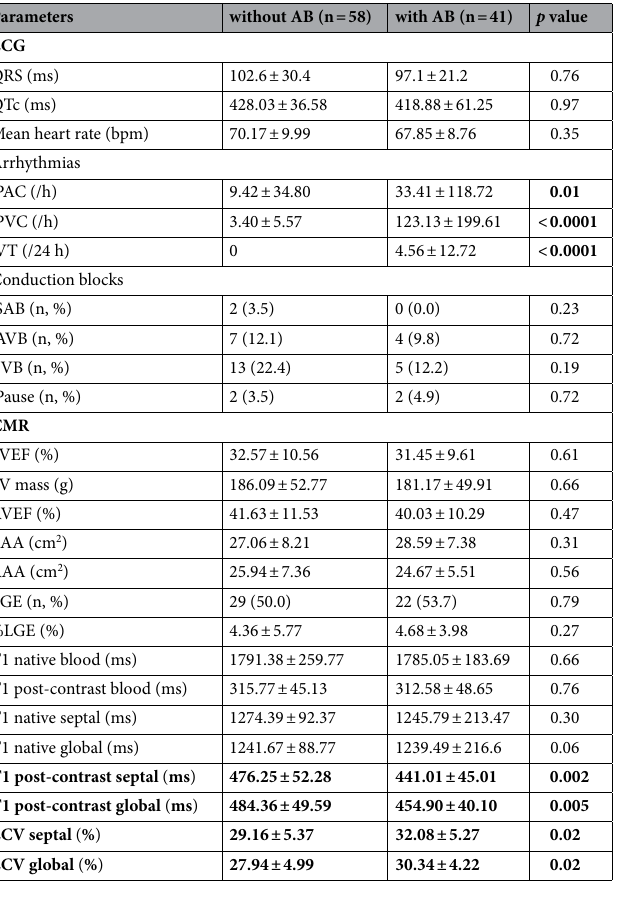
Table 2. Comparison of ECG and CMR findings between DCM patients with and without AB. Values are mean ± SD or n (%). AB arrhythmic burden, ECG electrocardiogram, QTc corrected QT, PVC/PAC premature ventricular/atrial contractions, 24 h/h 24 h/hour, VT (non-sustained or sustained) ventricular tachyarrhythmia, SAB sinoatrial block, AVB atrioventricular block, IVB intraventricular block, pause pause > 3 s, CMR cardiovascular magnetic resonance, LV/LVEF left ventricle /LV ejection fraction, LAA/RAA left/right atrial area, LGE late gadolinium enhancement, %LGE extent of LGE, ECV extracellular volume, septal mean value of 8- and 9-segment.